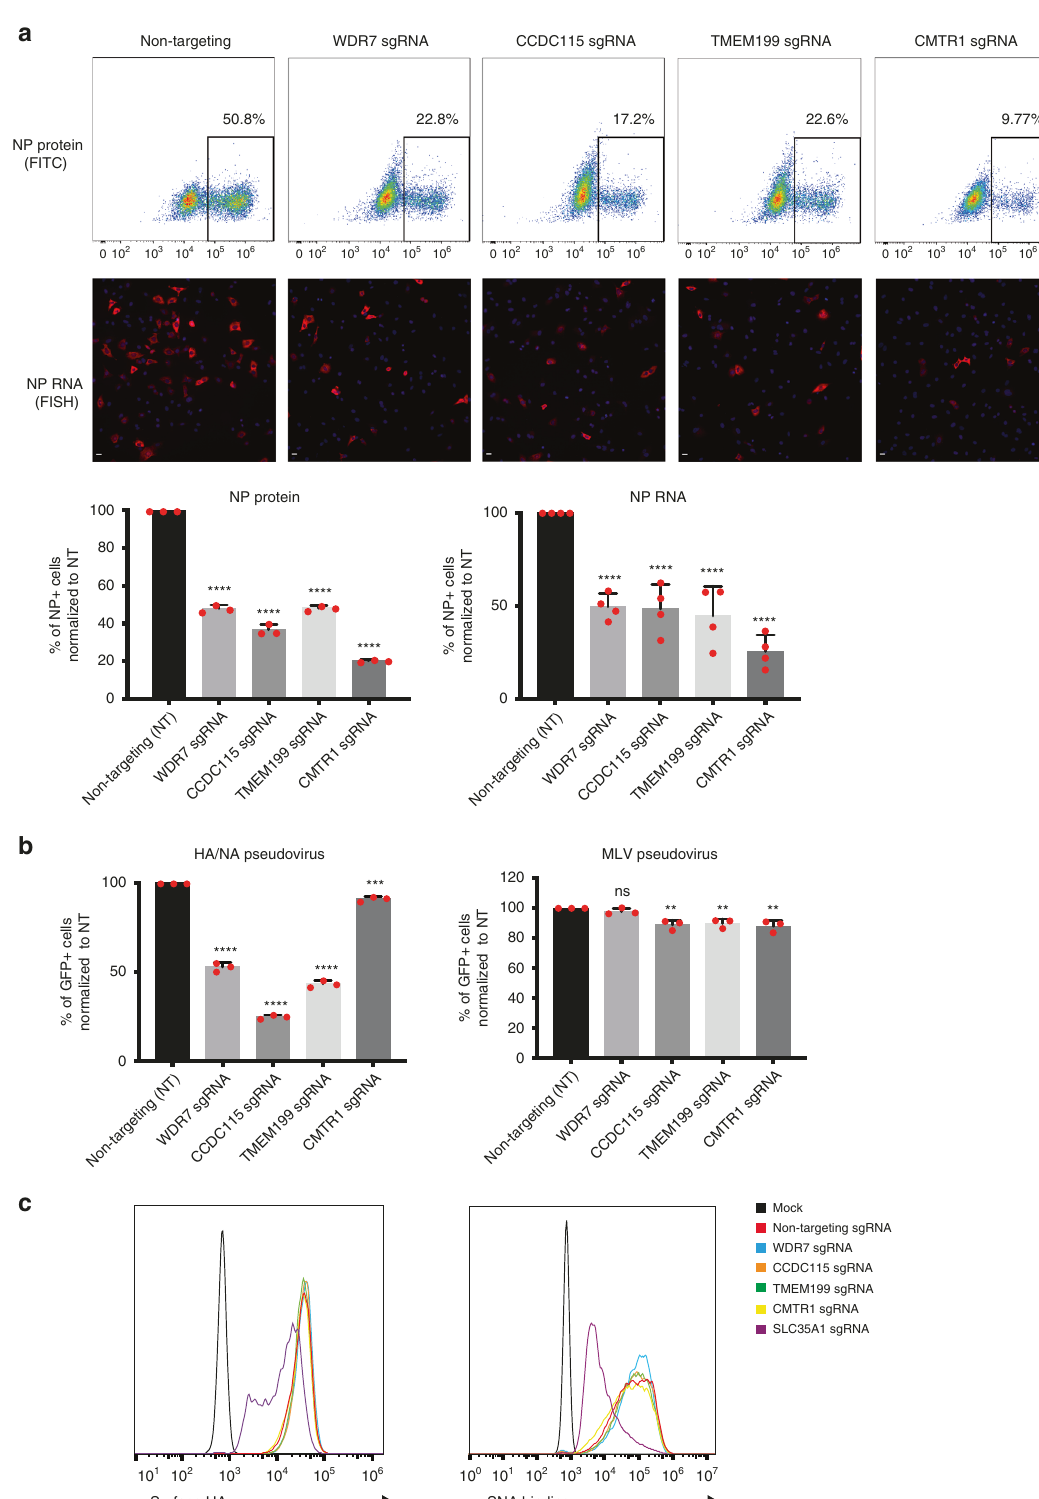
of WDR7, CCDC115 and TMEM199 KO cells and a correspond- ing reduction in the membrane fraction, indicating that at least a subset of V-type ATPases are in a dis-assembled and less active state in these cells (Fig. 5d). This was unexpected as inactivation of the V-type ATPase should in theory lead to less endo- lysosomal acidi fi cation. It has been reported that prolonged treatment of cells with lysosomotropic compounds such as